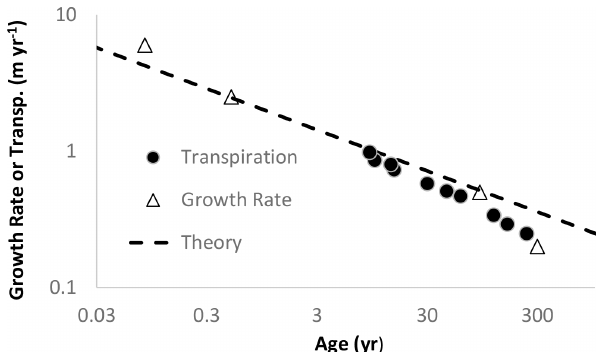
Figure 1. Growth rates and transpiration rates of eucalypts (i.e., data from Roberts et al., 2001; Givnish et al., 2014). The unknown parameter x 0 /t 0 is estimated from the precipitation, which is vari- able in the study region but typically about 2myr − 1 where the trees were found. The 3D value of the optimal path exponent (shown) is in much closer accord (than the 2D value) with the data over the en- tire age range from 1 month to 300 years. The extracted parameters for transpiration and tree height as functions of time were not dis- tinguishable (a ca. 4% difference in individual parameter